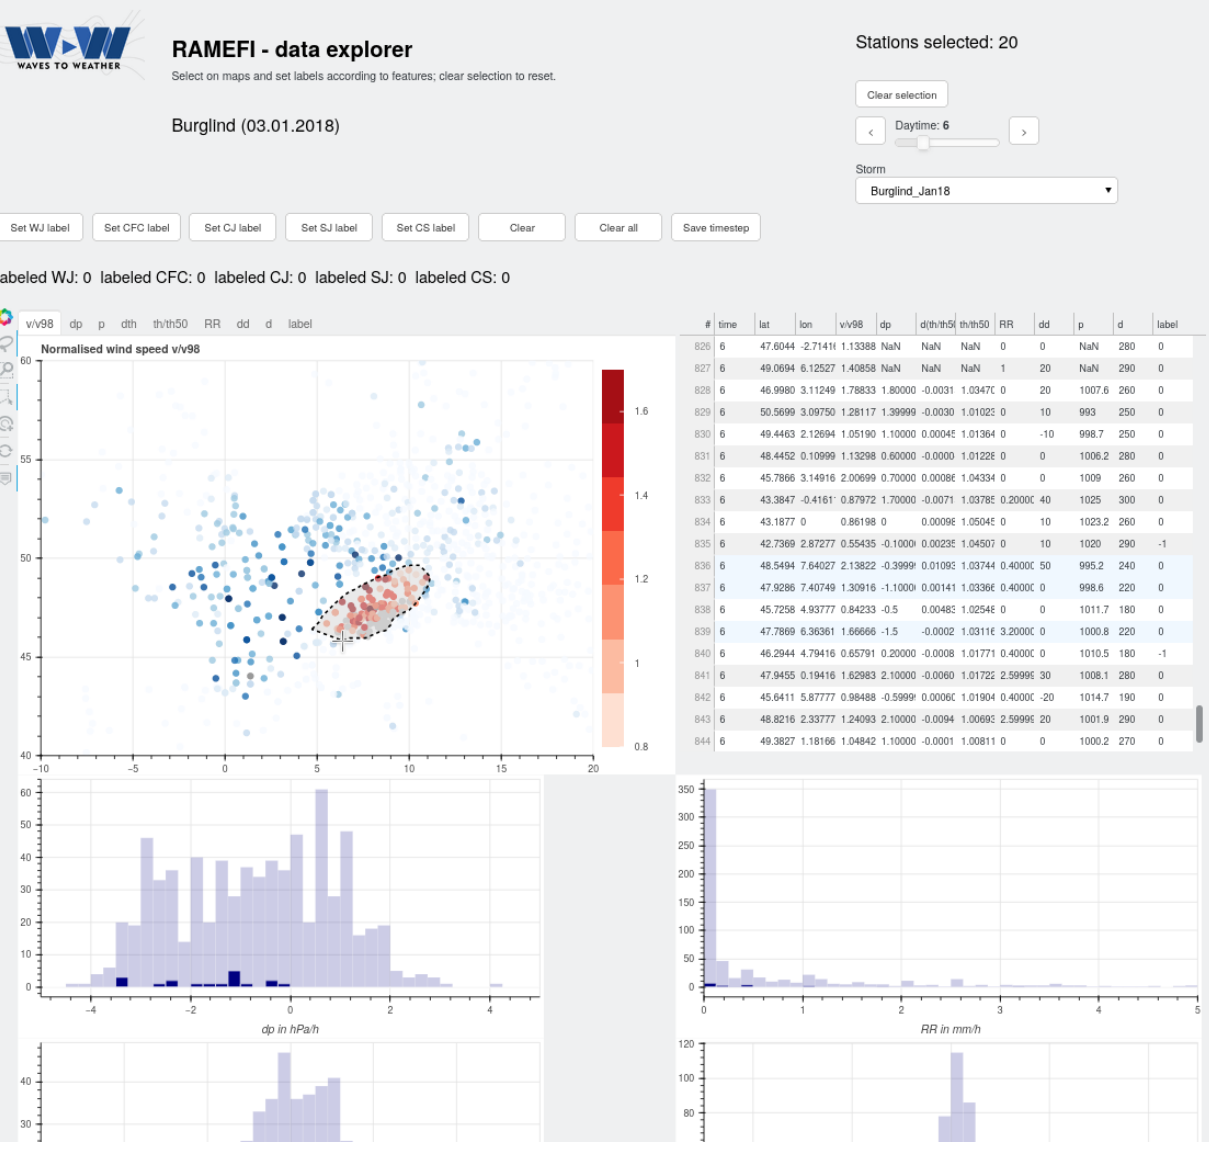
Figure D1. Screenshot of the interactive visualisation and labelling tool as part of RAMEFI (Eisenstein et al., 2022a) using the Bokeh (Bokeh Development Team, 2021) Python package. The user can switch between time steps and loaded winter storms. The top row shows a map of stations and their parameters, here ˜ v , where the user can select an area by mouse with the lasso tool or by clicking on single stations. Labels for the introduced features can be set for the selected stations. A table includes all data points and parameters. Histograms are shown for several parameters for the whole region (light blue) and for currently selected stations (dark